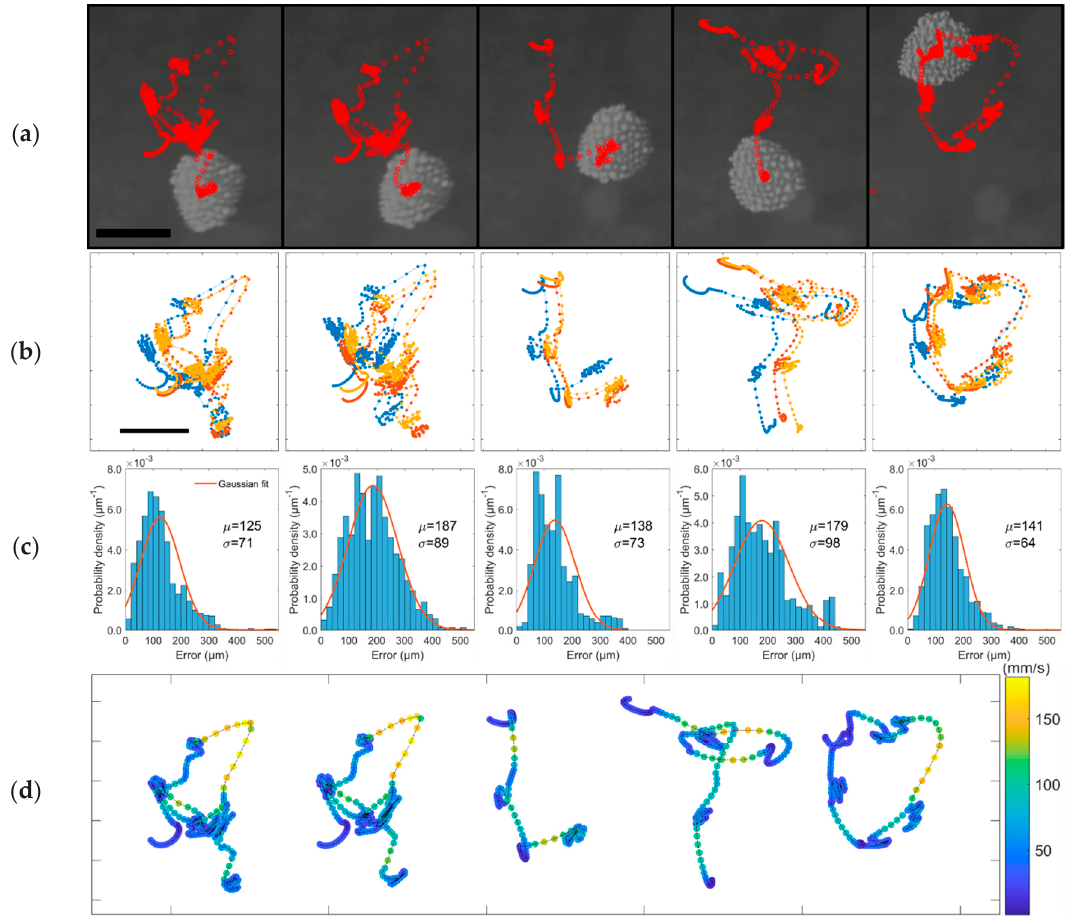
Figure 8. ( a ) Trajectory following results forming the letters AALTO. The red circles indicate the position of the microspheres cluster at each video frame (frame rate is 1000 FPS). ( b ) Trails for three repetitions of the trajectory following the experiment. ( c ) Position error histogram and corresponding Gaussian fit; the error is measured as the deviation from the mean trajectory of all repetitions. ( d ) The distribution of speed of the cluster on the mean trajectories. The scale bar is 1 mm in ( a , b ).